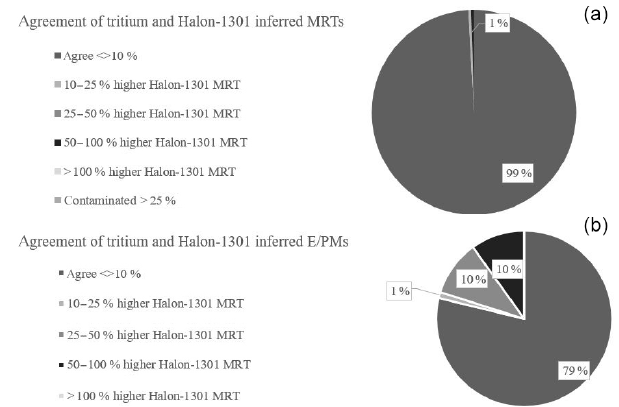
Figure 9. Summary of the performance of Halon-1301 as an age tracer compared to tritium in predicting the MRT (a) and the mix- ing parameter E / PM (b) . Overall, at 99% of the sites MRTs agree within ±